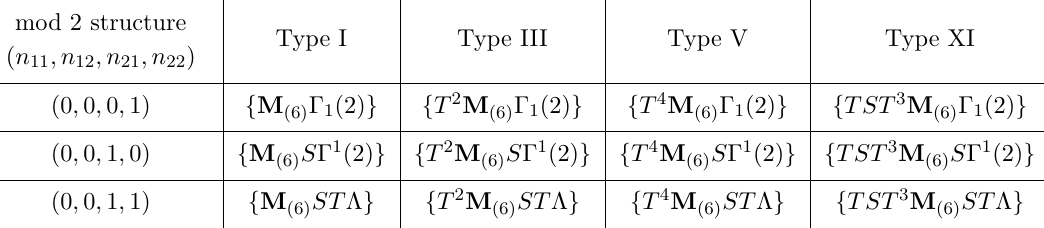
Table 15 . Classification of Types I, III, V, XI for D = 6 .